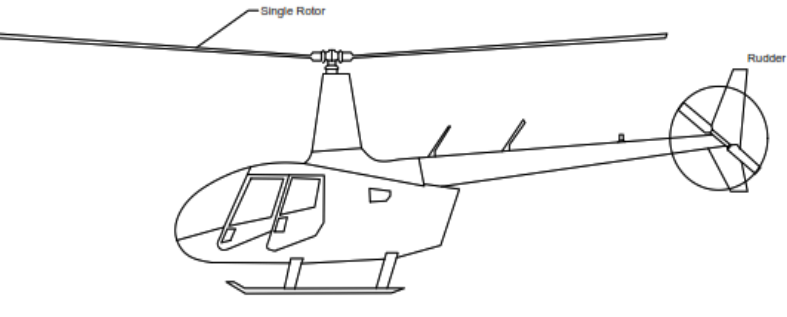
Figure 4. Single rotor.